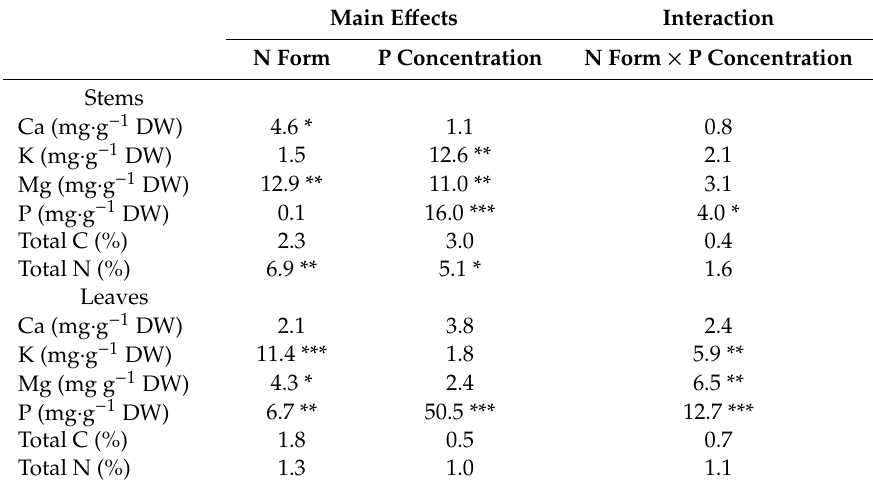
Table 2. Results of two-way ANOVA (F-ratios) of nutrient minerals in the tissue of hybrid Napier grass ( Pennisetum purpureum × P. americanum ) grown on di ff erent N forms (NH 4 + , NO 3 − , or NH 4 NO 3 ) and P concentrations (100 and 500 µ